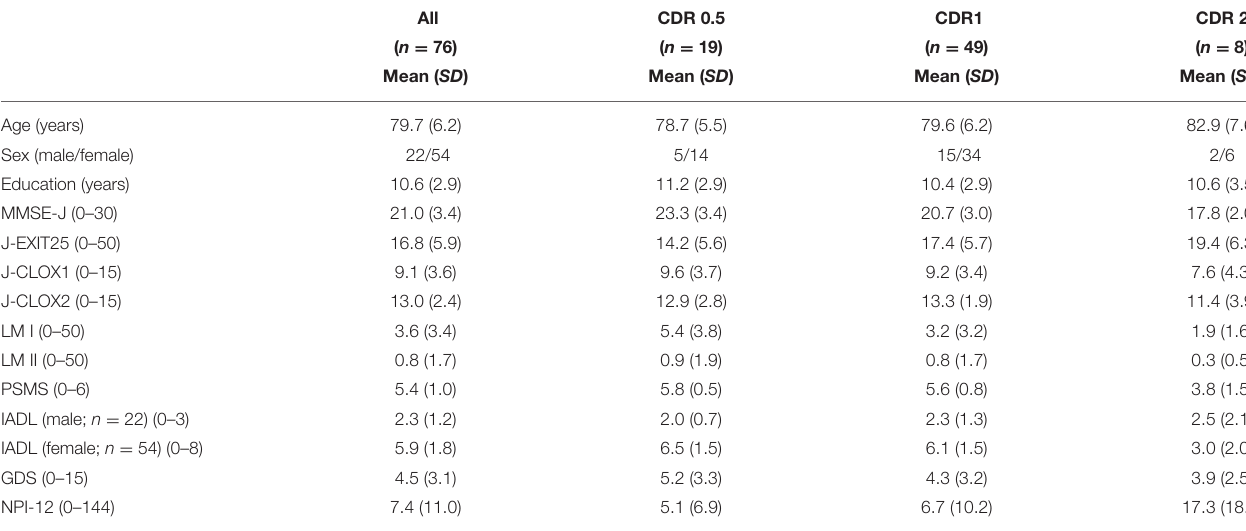
TABLE 2 | Demographic and clinical